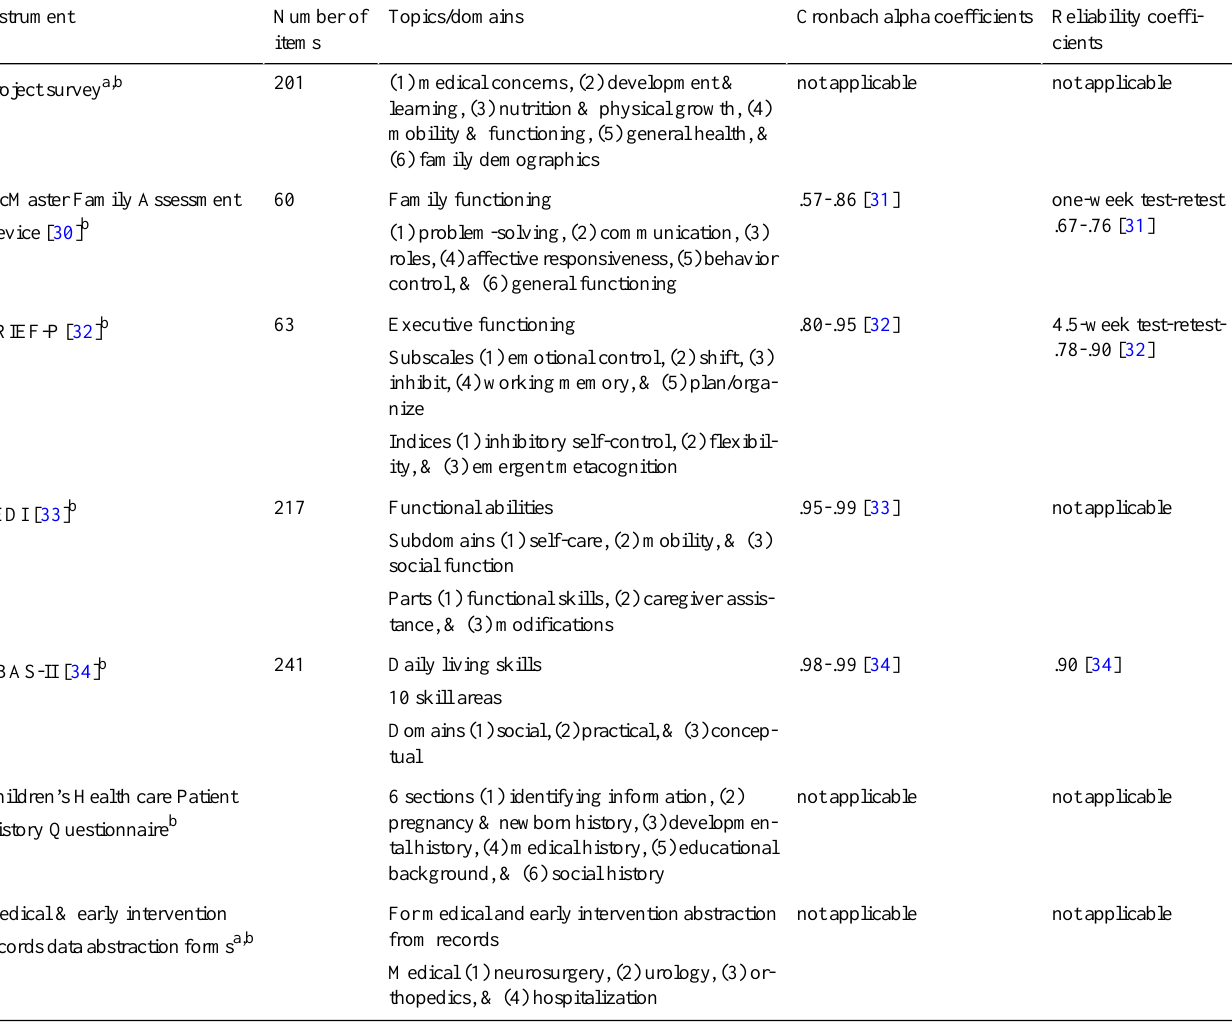
Table 1. Parent administered instruments to be